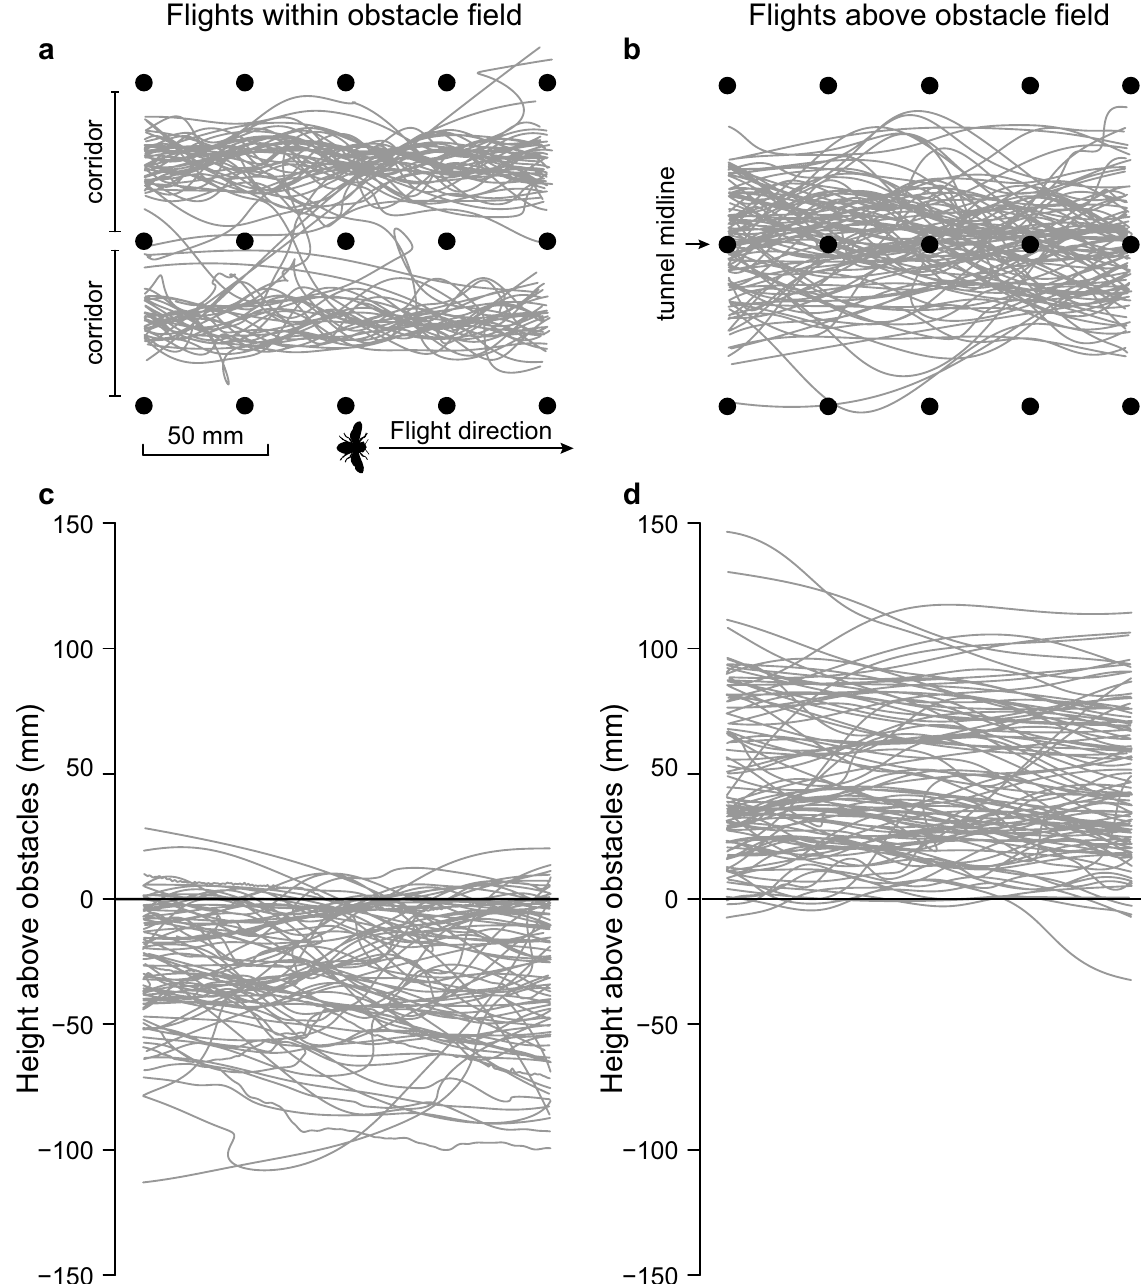
Fig 3. Digitized flight trajectories for bees flying within (a, c) and above (b, d) the obstacle field. Panels (a) and (b) show trajectories from a top-view, illustrating the longitudinal and lateral extent of the flight paths. Panels (c) and (d) show trajectories from a side-view, illustrating the longitudinal and vertical extent (relative to the top of the obstacle field) of the flight paths. All 82 flights within the obstacle field are shown, but for clarity, traces of only 100 of the 466 flights above the obstacle field are shown.